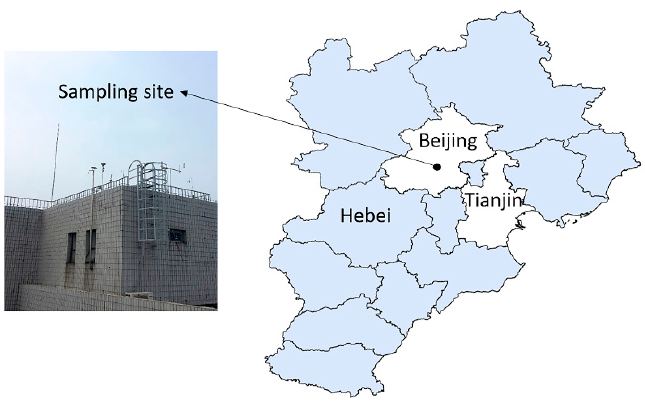
Figure 1. Location of the sampling site in this study.